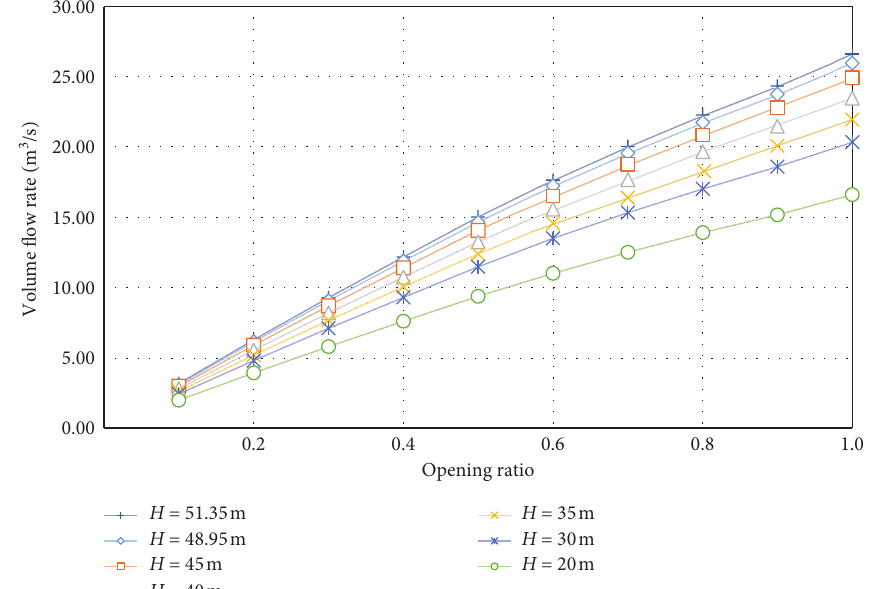
Figure 2: The volume flow rate at different openings and heads.